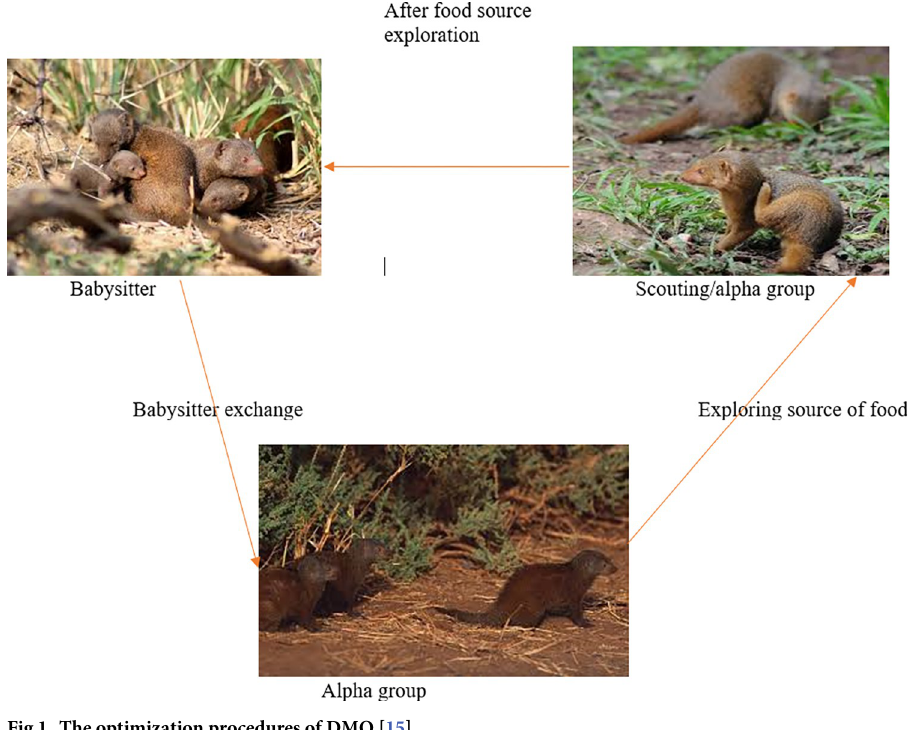
Fig 1. The optimization procedures of DMO